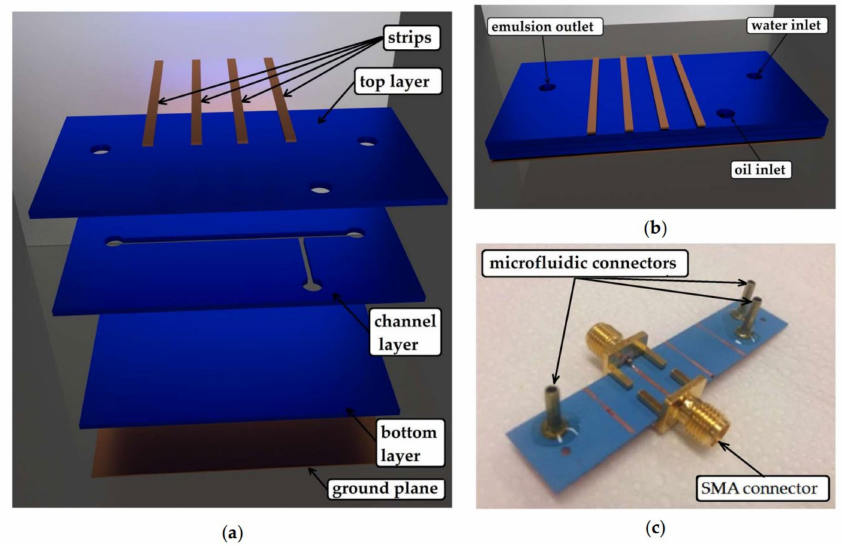
Figure 18. The scheme of a microfluidic-microwave device for measurements of droplets; the view of layers consisted of the module ( a ), the top view of the device ( b ), and the picture of the fabricated device ( c ) [102].